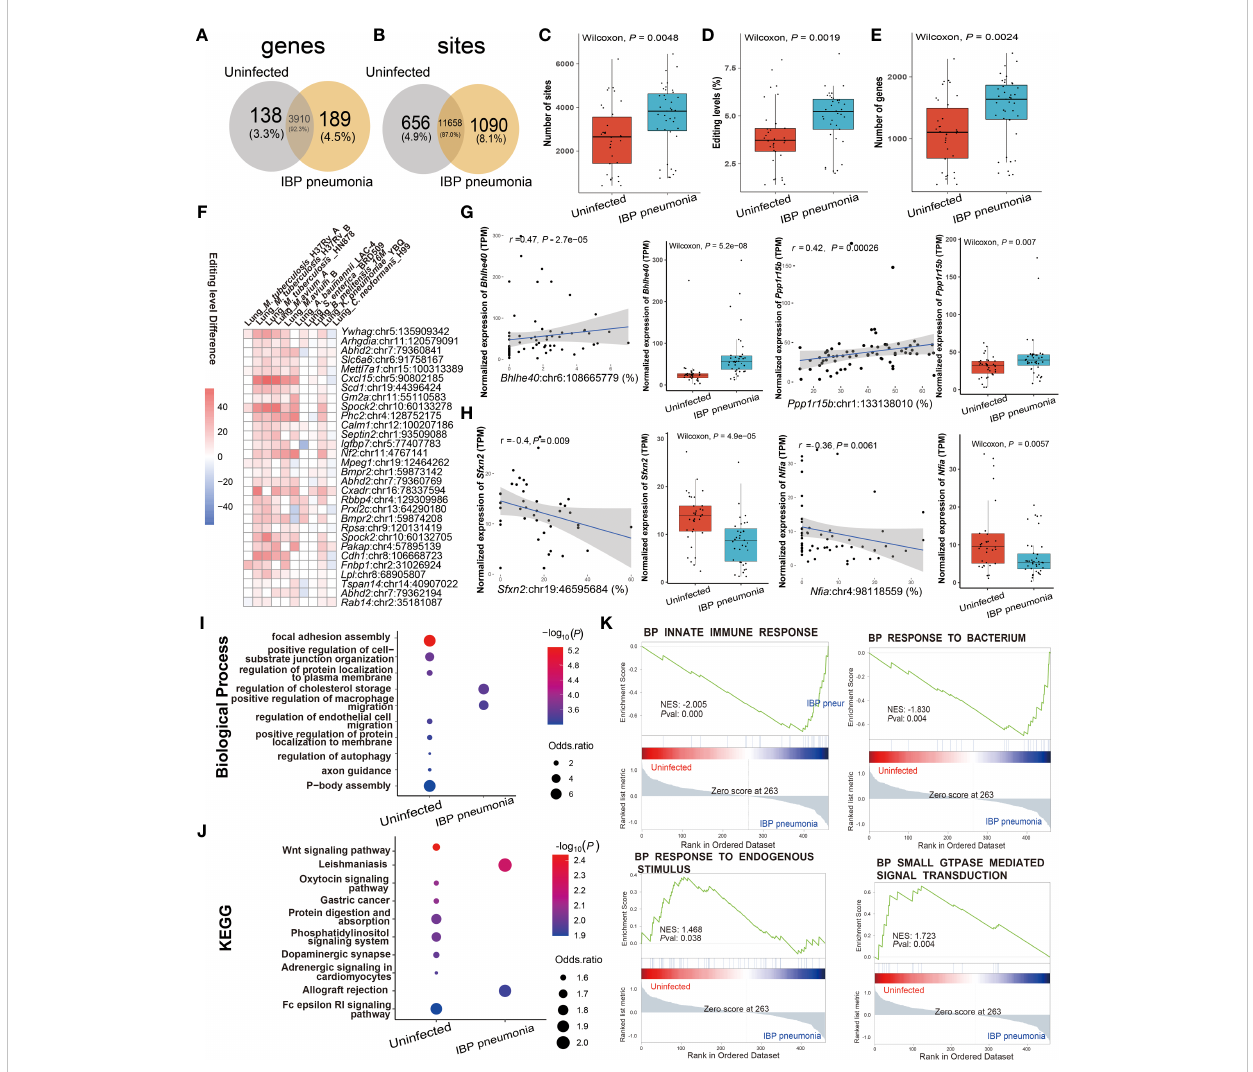
FIGURE 3 RNA editing alteration in IBP pneumonia. (A) Venn plot comparing the genes with A-to-I editing between the combined infected and uninfected groups. (B) Comparison of A-to-I RNA editing sites between the combined infected and uninfected groups. (C) The number and (D) editing level of A-to-I RNA editing sites, and (E) the number of A-to-I RNA editing genes. (F) Top 30 DRE sites shared by at least six pneumonia datasets. Each square represents the difference in the editing level of the edited site (the infected - the uninfected, all GLM test P < 0.05). (G, H) Spearman correlation between gene expression and editing level of Bhlhe40, Ppp1r15b , Sfxn2 , and N fi a . Items with the most signi fi cant P -values are shown for (I) biological processes and (J) KEGG pathways. Selected GSEAs of DRE genes are listed in (K) GLM, general linear